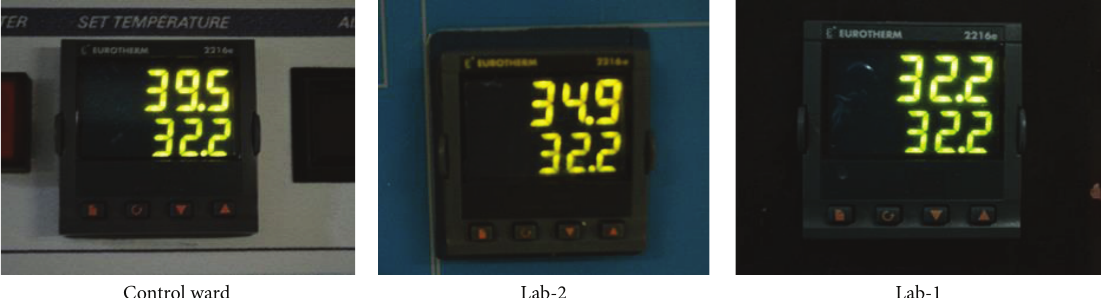
Figure 7: Incubator performance on typical extreme hot day of October 17, 2012. Readout top (actual chamber temperature) and bottom